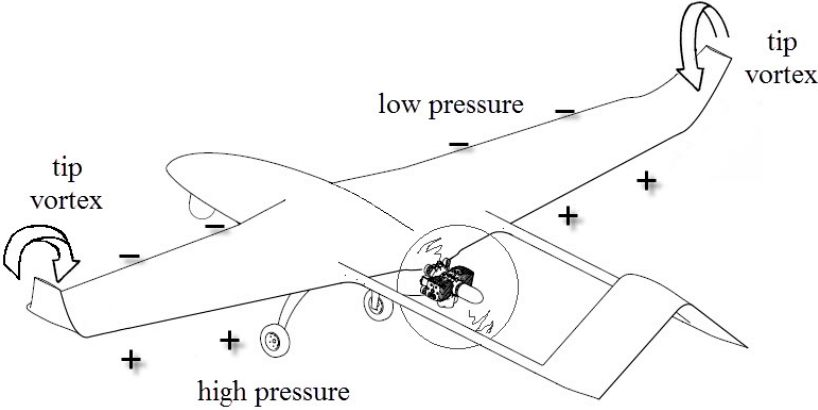
Figure 1. Tip vortex formation [7].